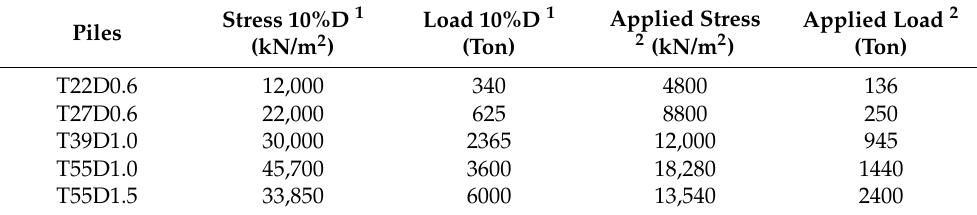
Table 4. Applied Table 4. Applied loads.